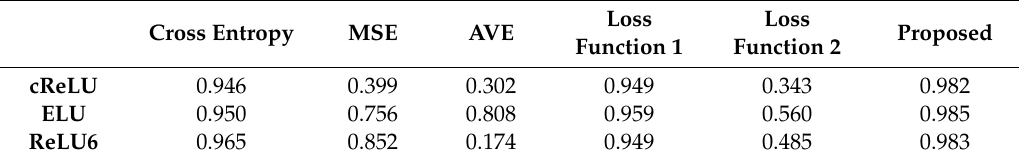
Table 6. Performance on various loss functions based on cReLU/ELU/ReLU6.